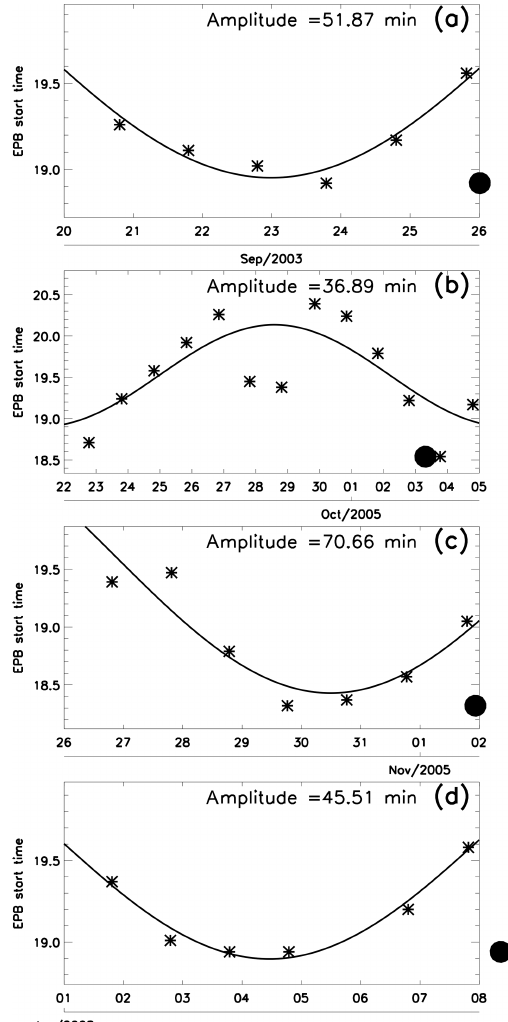
Figure 2. Start times of plasma bubbles (stars) as functions of time. Solid line represents the best fit to a sinusoidal oscillation with a period of 14.5d. The respective amplitudes are shown at the middle top of the panels. Panel (a) shows the results for September 2003. Panel (b) shows the results for September–October 2005. Panel (c) shows the results for October–November 2005. Panel (d) shows the results for January 2008. Filled circles indicate the new moons.